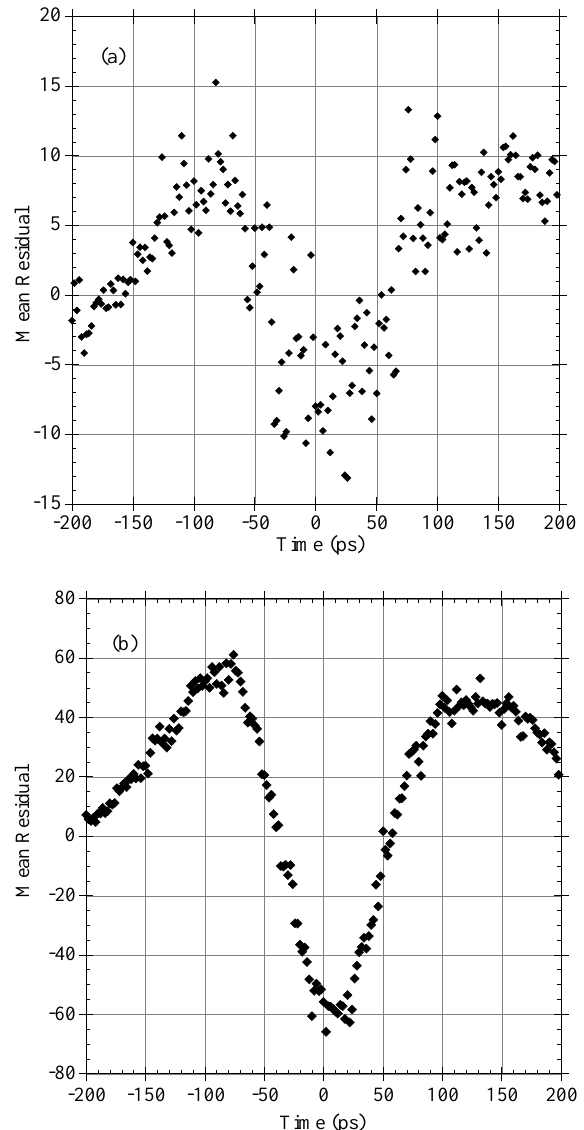
FIG. 29. The mean residual of the bunch distributions between the current of (a) 183–160 mA and (b) 262–247